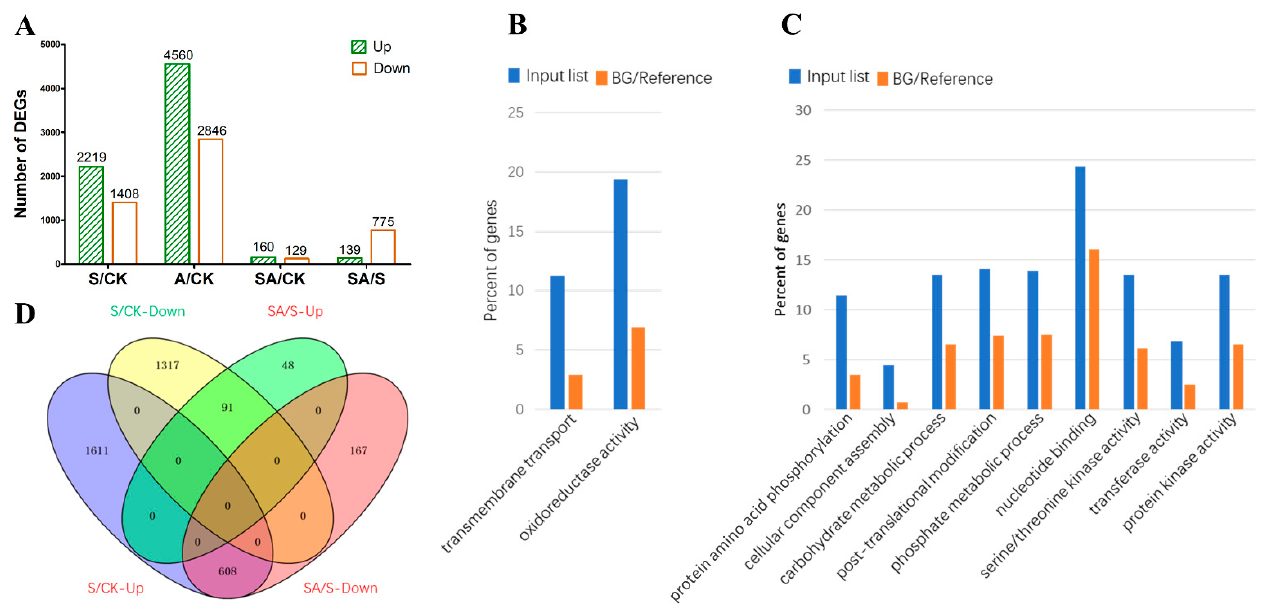
Figure 3. Overview of the transcriptome profiling analysis and the GO enrichment analysis of the differentially expressed genes (DEGs) in C18 seedlings. The DEGs in the C18 seedlings revealed by the salt (S) vs. control (CK), allantoin (A) vs. CK, SA vs. CK, and SA vs. S comparisons ( A ). The enriched GO terms among the upregulated genes ( B ) and the downregulated genes ( C ) revealed by the SA vs. S comparison. A Venn diagram was constructed to analyze the up- and downregulated genes detected by the S vs. CK and SA vs. S comparisons ( D